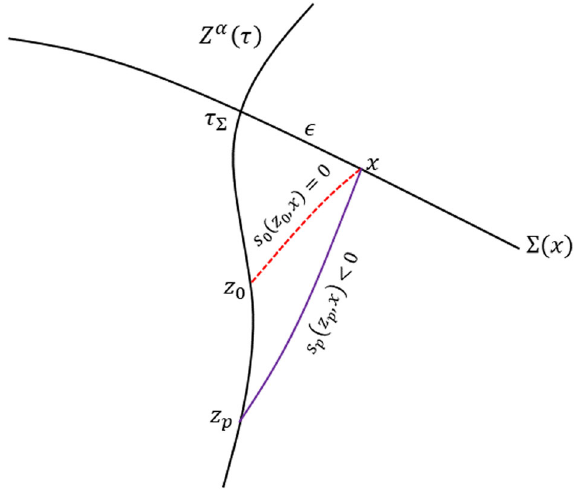
Fig. 1 Adiagramofradiationsatthefieldpoint x onaspacelikehyper- surface (cid:14)( x ) . Z α is the 4-velocity of the charged source